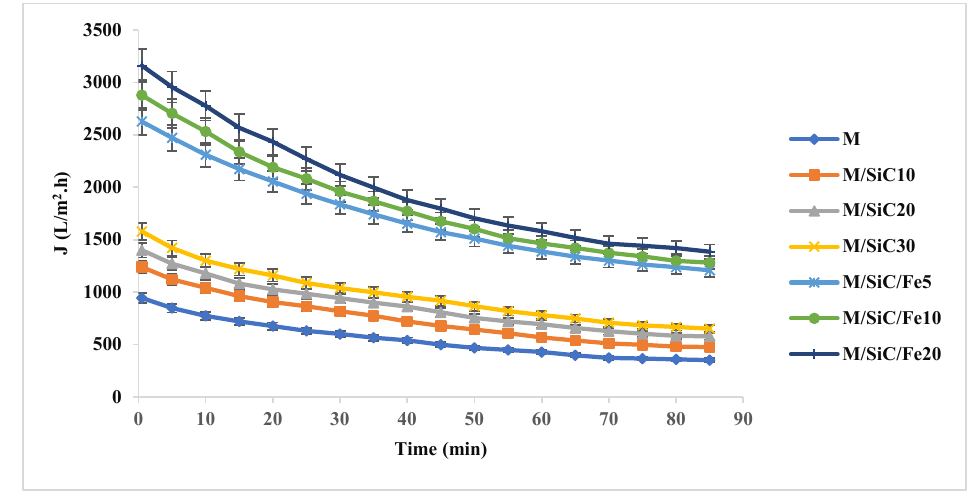
Figure 10. Variation of J of the fabricated microfiltration membranes as a function of time at 1 bar constant pressure.